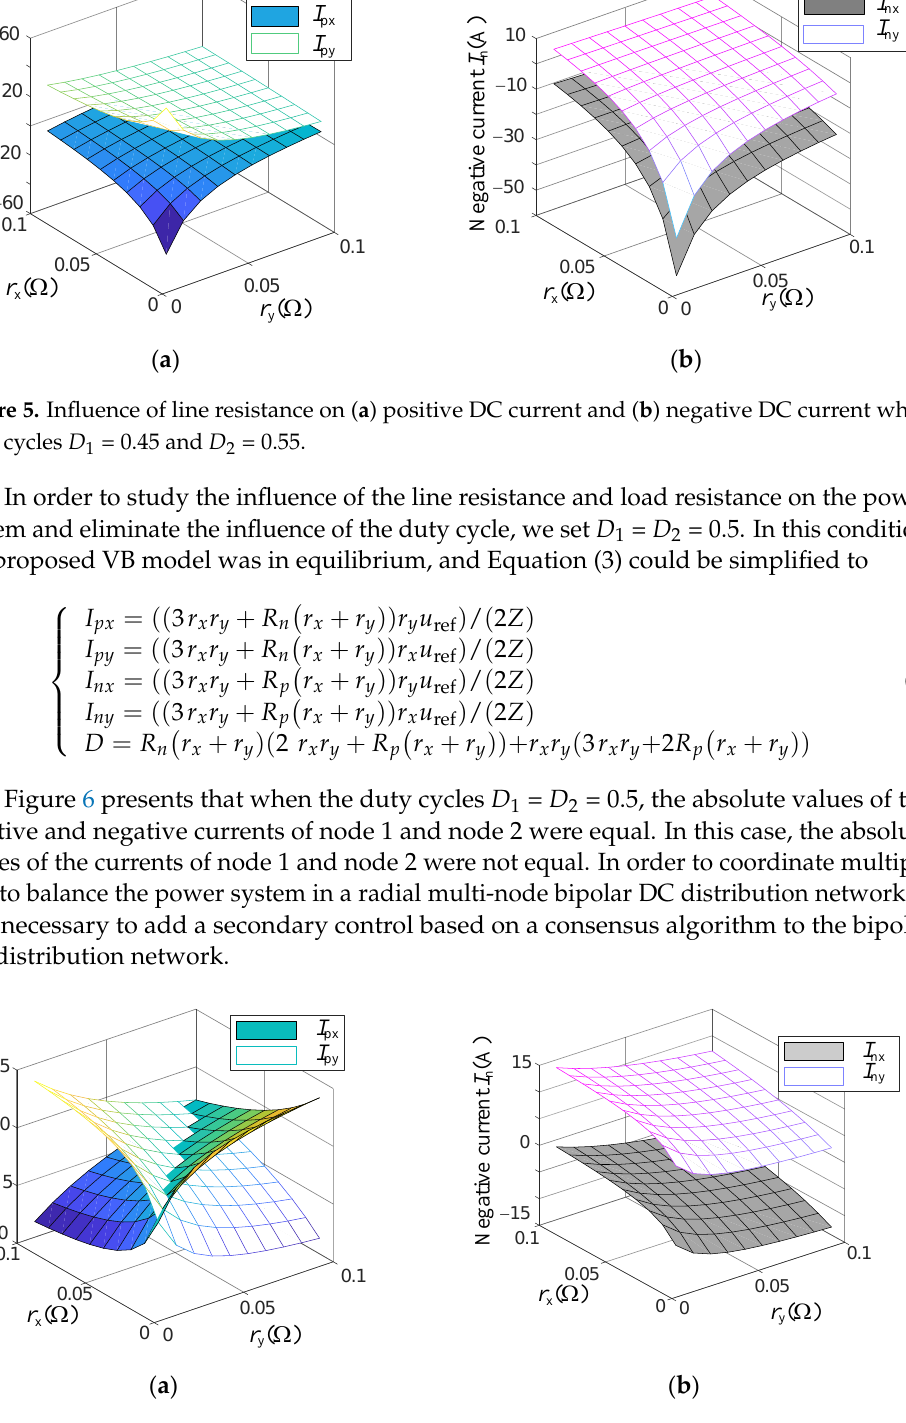
Figure 7. Block diagram of multi-node bipolar DC distribution network with consensus control. Figure 3 presents the structure of the bipolar DC distribution network with a half- bridge VB. When the constructed grid structure was in normal operation, the switches Q 1 and Q 2 in the VB adopted complementary PWM control, because the main objective of this study was to ensure the balance of positive and negative bus voltages in the bipolar DC distribution network. By setting the duty cycle of the switch Q 1 to d 1 , the duty cycle of